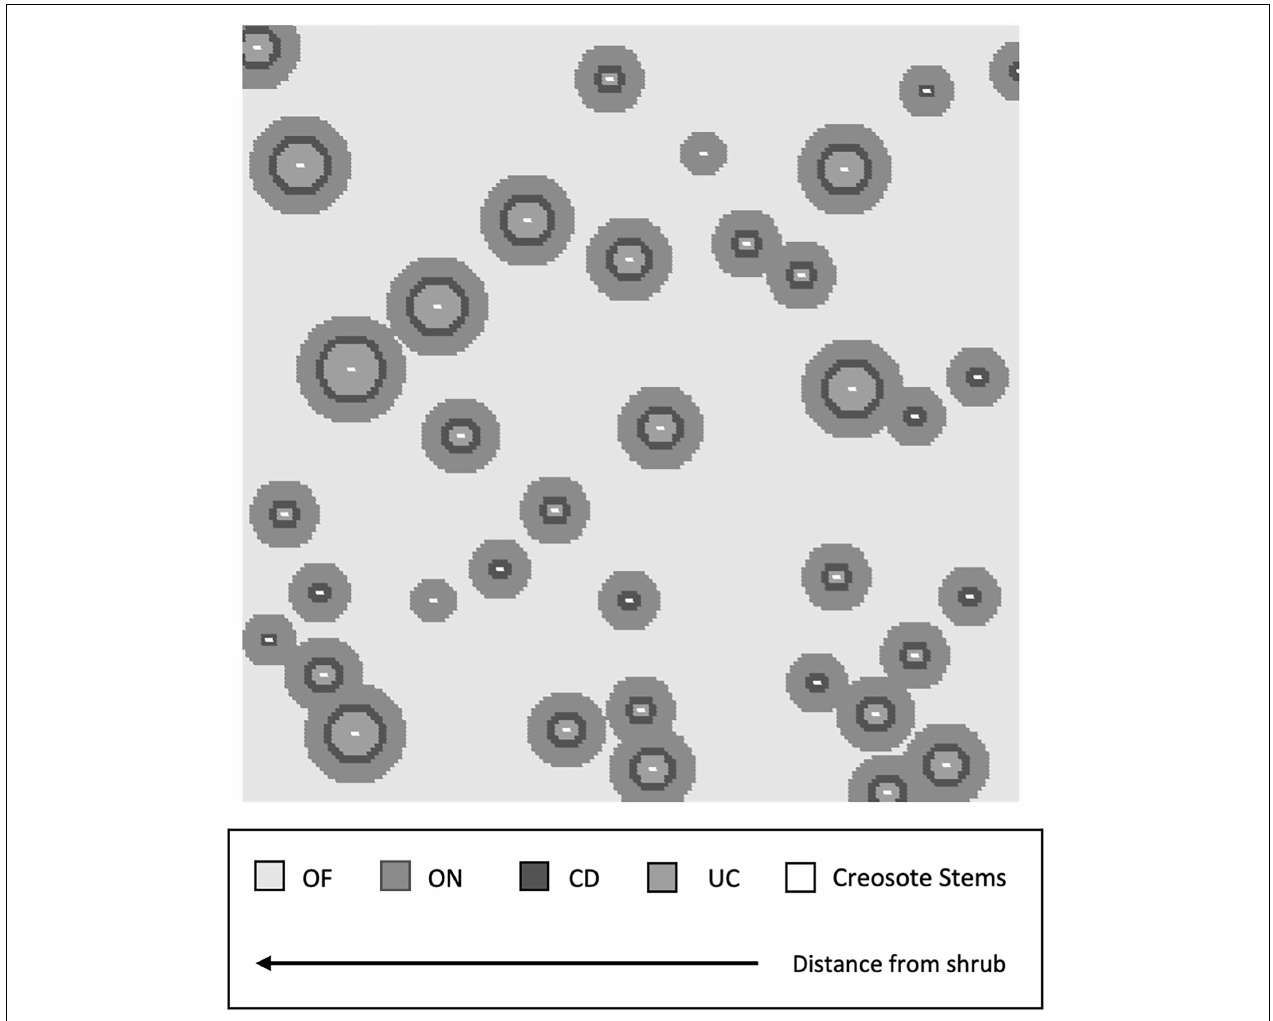
FIGURE 4 | Example of habitat zones in the Shrub Island